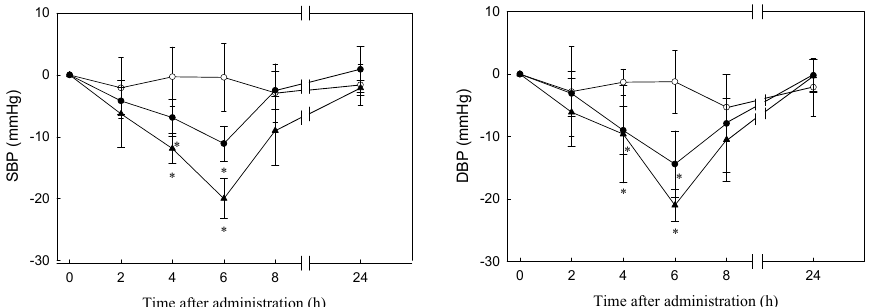
Figure 3. Changes in blood pressure of SHRs after oral administration of PN-1. ( a ) SBP; ( b ) DBP. —O—, 0.9% NaCl in water as control; — ● —, 30 mg of C. sorokiniana protein hydrolysate powder with 0.9% NaCl; — ▲ —, 60 mg of C. sorokiniana protein hydrolysate powder with 0.9% NaCl. Each point represents a mean value ( n = 6) and the vertical bars represent the standard errors. *: significant